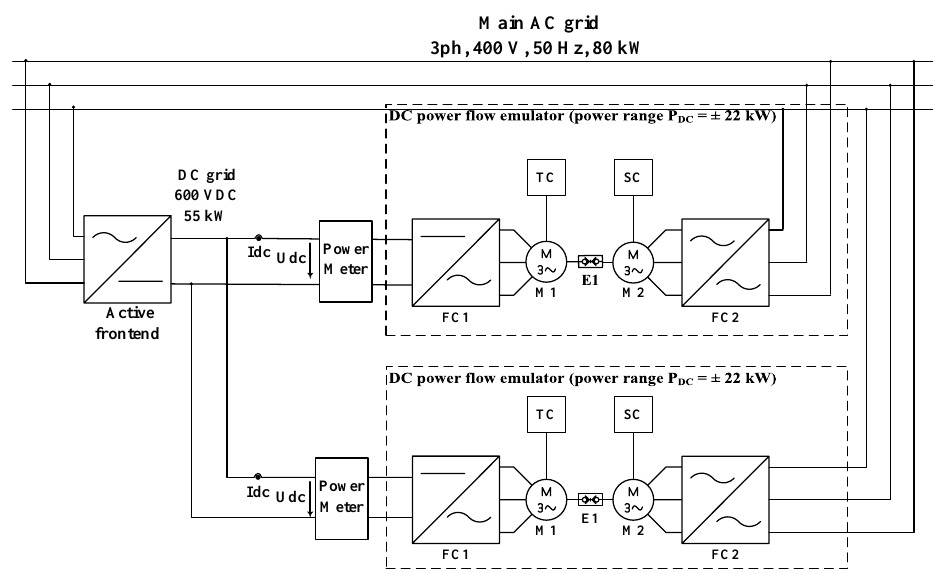
Fig. 6. Structure of DC testing system and measurement